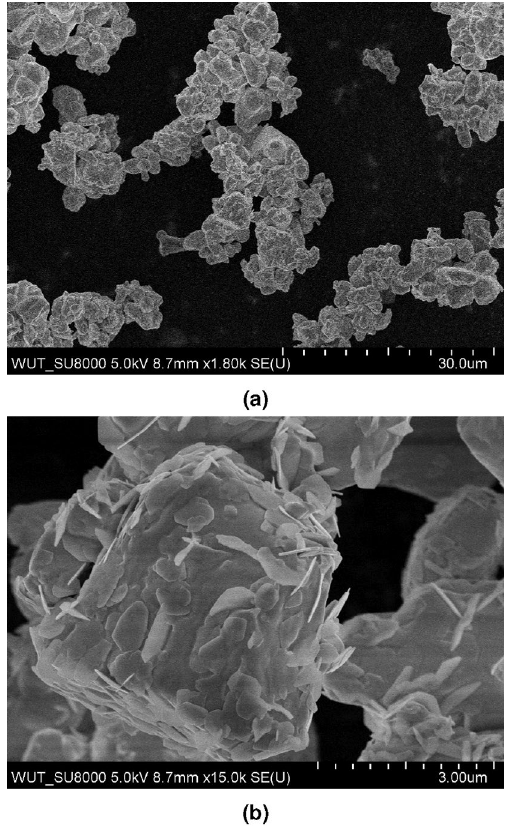
Figure 4. SEM images acquired at different magnifications of the starting Bi 2 O 3 powder used for all syntheses in this work. Two different parts of the reagent with various magnifications represent typical shapes of grains.